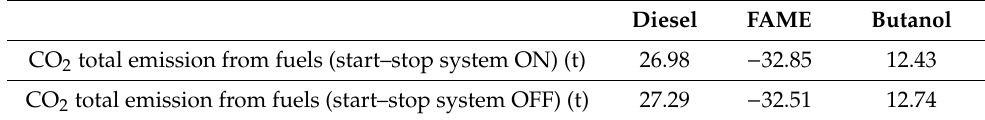
Table 9. Total carbon dioxide emission from analyzed fuels during life